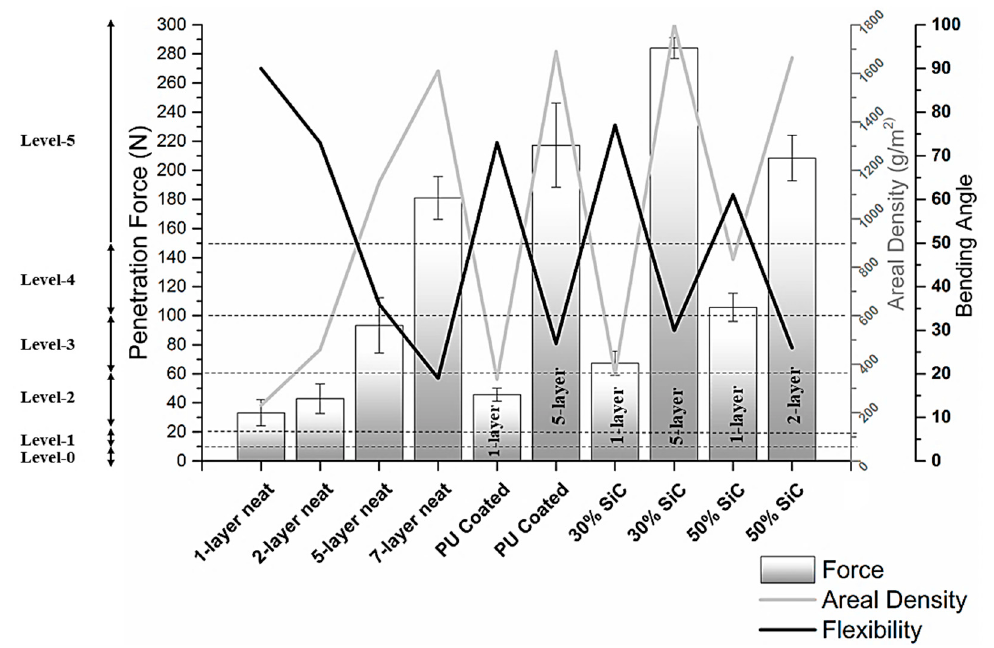
Figure 6. Measured peak resistance force, bending angle, and areal density of plasma-treated neat and coated UHMWPE fabrics of various layers undergoing spike penetration tests.